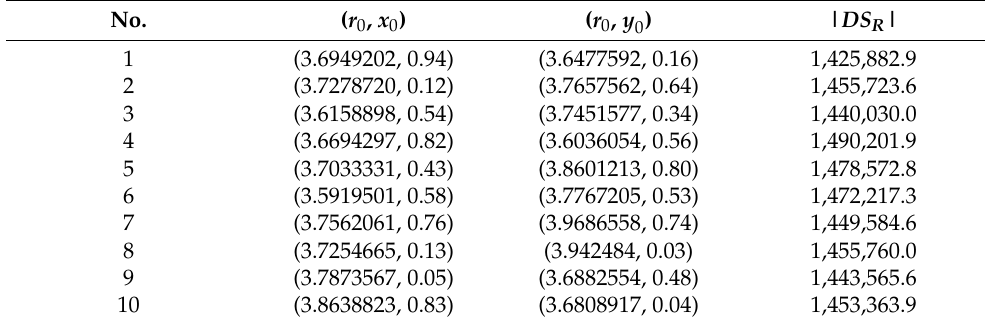
Table 2. Comparisons of relative configurational entropy of confused DEM A under different keys in the first round. ( r 0 , x 0 ) and ( r 0 , y 0 ) denote the keys to scramble the row and column of DEM A, respectively. | DS R | means the absolute S R difference compared to the original one.